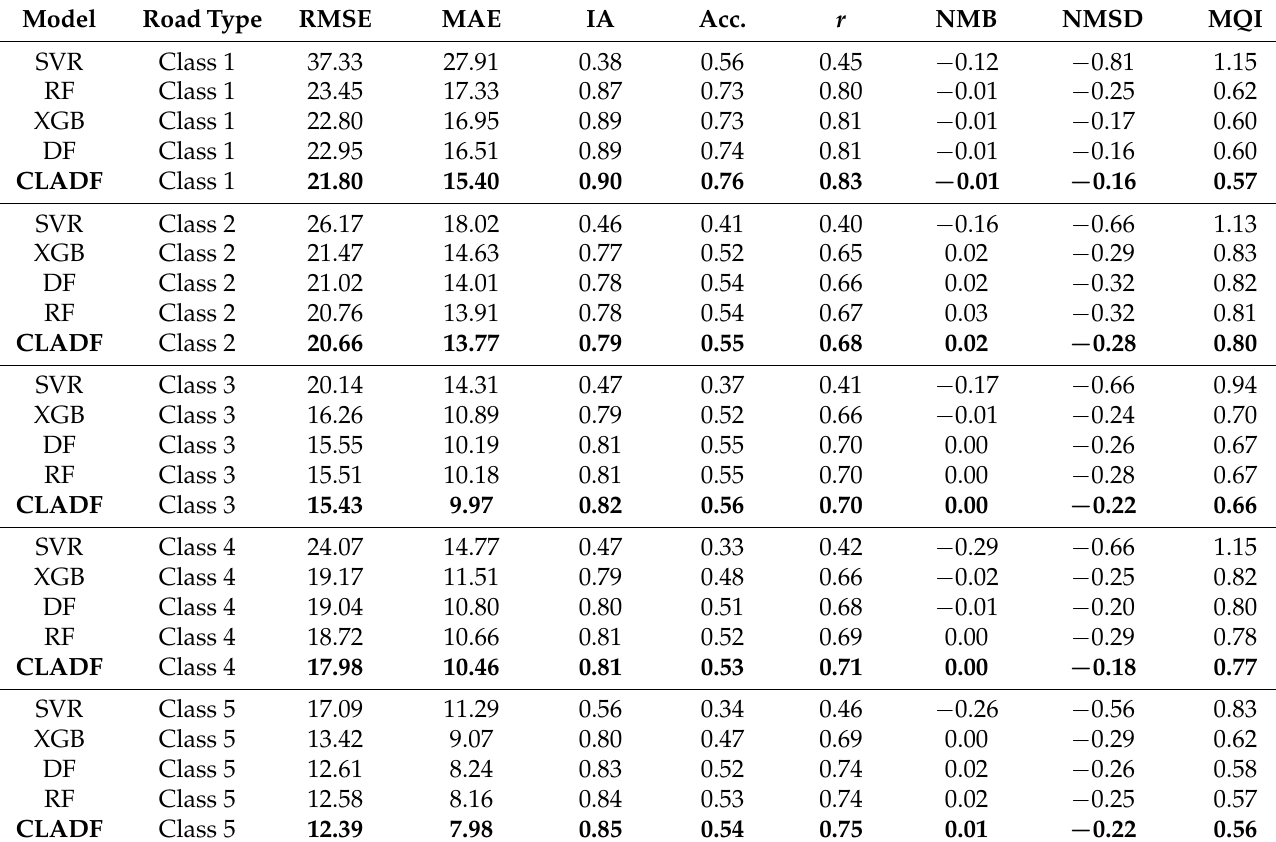
Table 4. Comparison of performance metrics of models on five different types of